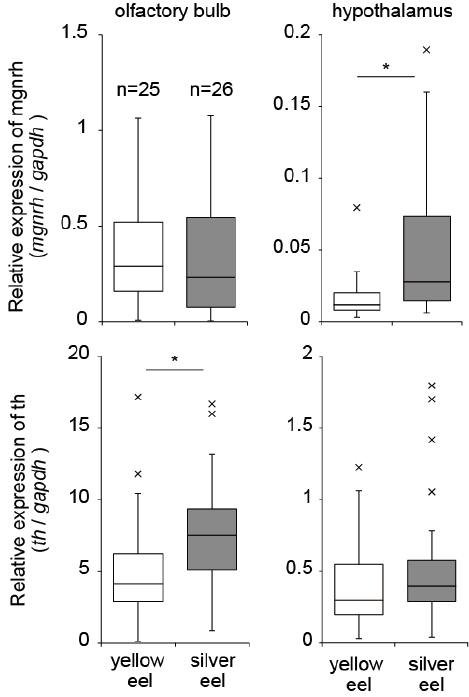
Figure 2. Relative expression levels of mgnrh and th in the olfactory bulbs and hypothalamus of Japanese eels ( A. japonica ) during silvering, as quantified by quantitative real time PCR. Asterisks indicate significant differences between yellow eels and silver eels ( p < 0.05; U-test). Cross marks indicate outliers. All samples were collected from a brackish lake (Hamana lake, Shizuoka prefec- ture, Japan). Eels were classed as yellow or silver, according to a silvering index [11]. Eels (n = 51) were sacrificed by decapitation while still anesthetized, and then their brains were quickly removed for molecular biological analysis. Expression levels of target genes ( mgnrh and th ) and a reference gene (glyceraldehyde-3-phosphate dehydrogenase, gapdh ) were measured using qPCR. Primers (mgnrhfw: 5′ -GACACCTCCAGTTTGCCCA- 3′ ; mgnrhrv: 5′ -TTGCCAGTATTTCCTTCAGGCT- 3′ ; thfw: 5′ -CTGCGTTCACGAGCTCTTAGG- 3′ ; thrv: 5′ -CAAGGCCAATGTTCTGAGAAAAC- 3′ ) and these assays were designed by Primer Express Software. For more detailed methods on the meas- urement of mRNA expression by qPCR, see Sudo et al. [42].